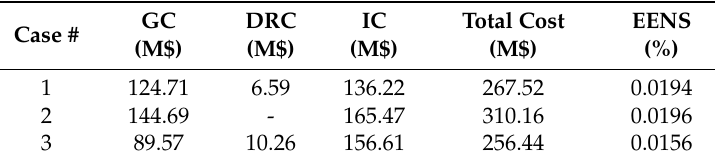
Table 1. Detailed results for cases 1–3.